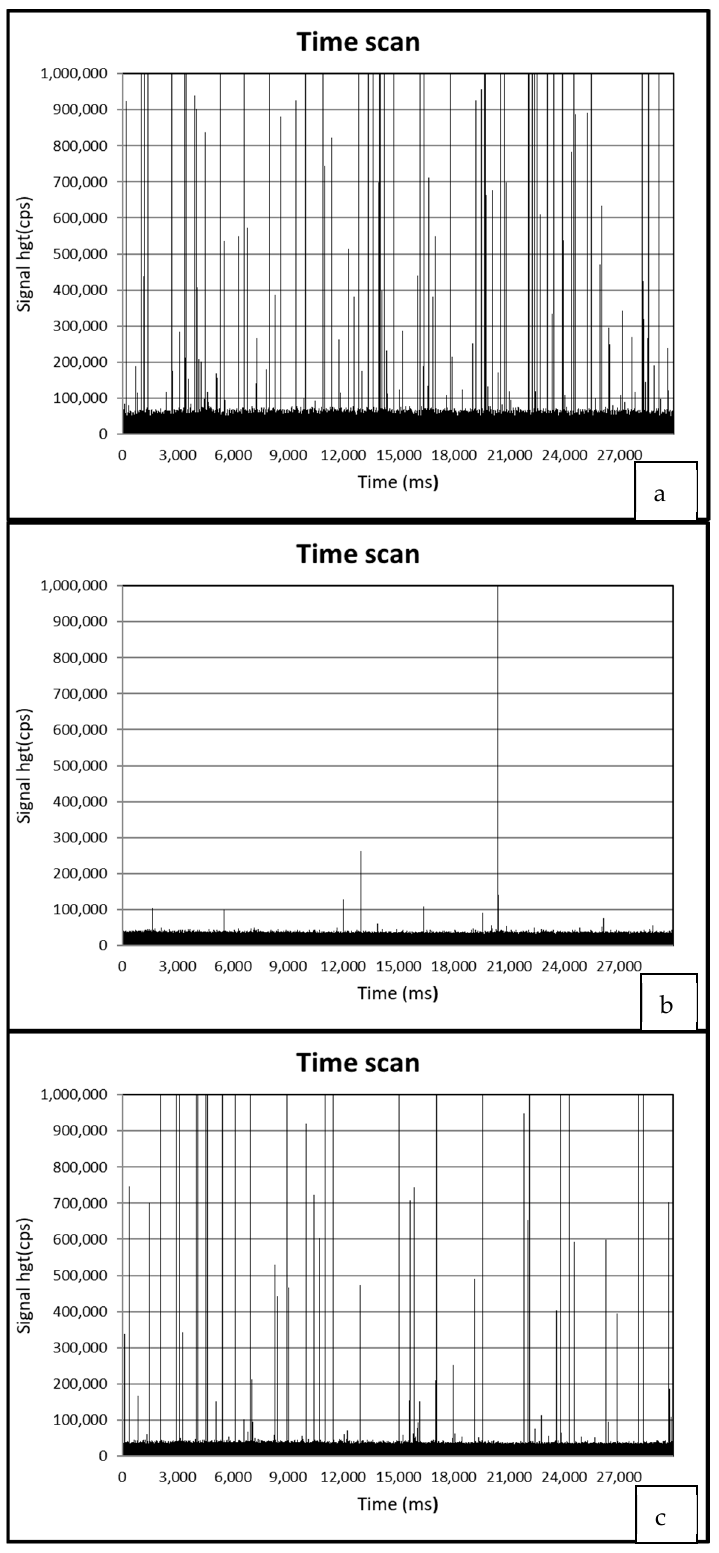
Figure 3. spICP-MS time scans of a mussel sample treated by TiO 2 NPs and ndl-PCBs (group 5) ( a ) and a mussel sample treated by ndl-PCBs only (group 3) ( b ) and a positive QC sample ( c ). In Figure 4, TiO 2 NPs concentrations calculated by spICP-MS in mussels (group 5 and 6 merged) before and after the depuration process are presented.